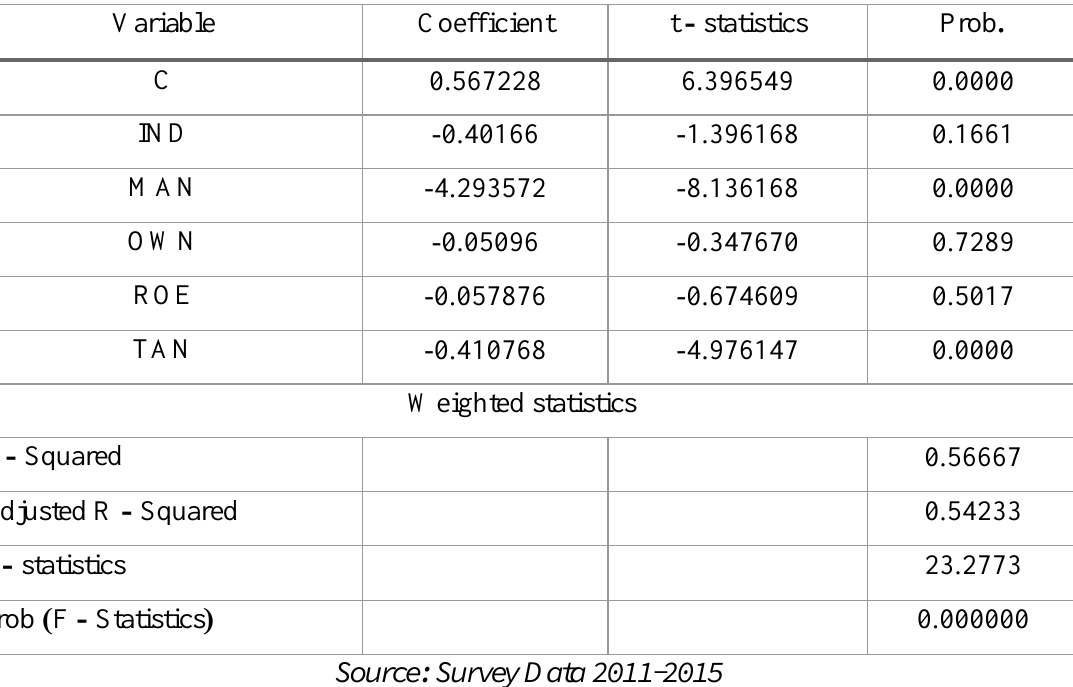
Table 04 – GLS test for Hotel